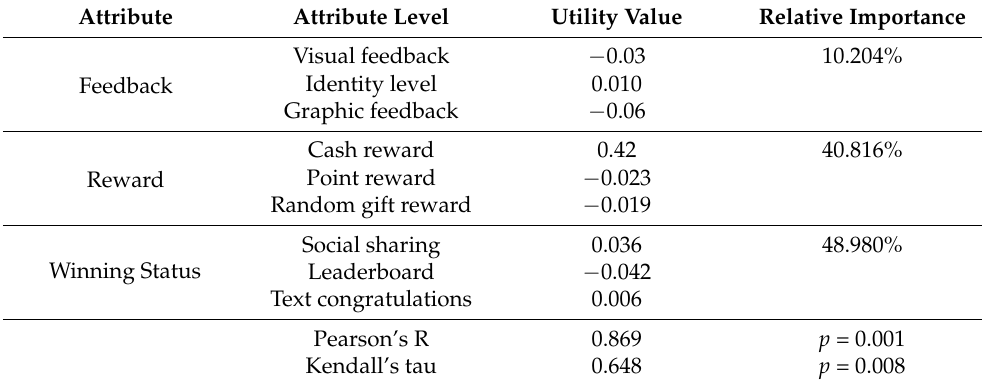
Table 6. Utility value of attribute levels for all